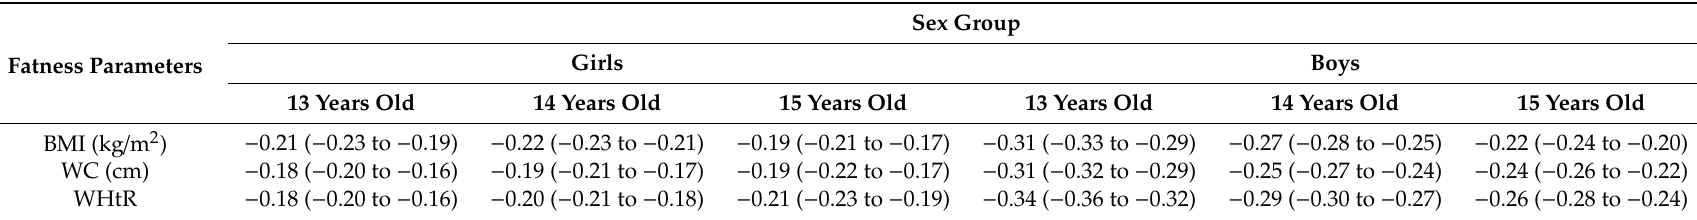
. V O 2 peak (20-meter shuttle run test) according to equation of L é ger et al. and fatness parameters by age and sex group. Table 2. Association between